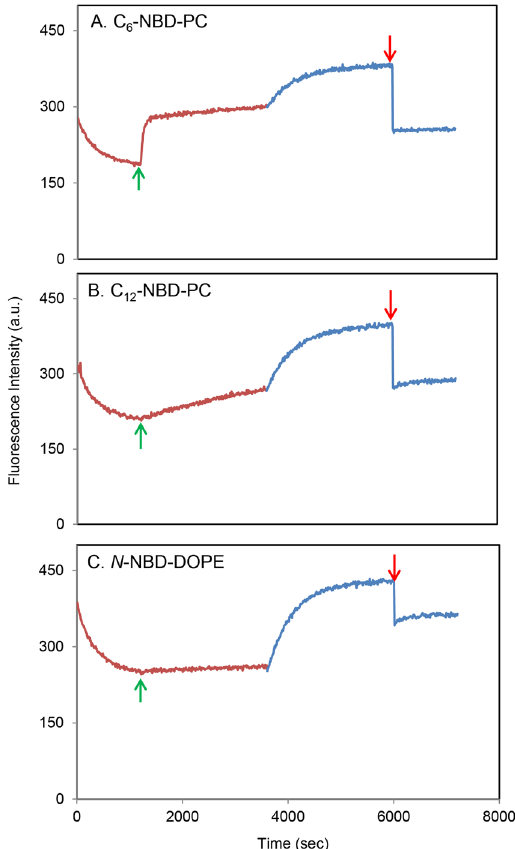
Figure 7. Spontaneous intermembrane transport of NBD lipids, C 6 -NBD-PC ( A ), C 12 -NBD-PC ( B ) and N -NBD-DOPE ( C ). Time course of NBD fluorescence emission in DOPC/ N -nitroBIPS-DPPG/NBD lipid (89:10:1) liposomes Representative data of three independent experiments. Red line, sample was concomitantly irradiated with blue green light (480 nm) and UV light (340 nm), activating NBD fluorescence quenching; blue line, sample was concomitantly irradiated with blue green light (480 nm) and green (543 nm) light, deactivating NBD fluorescence quenching; green arrow, indicates addition of acceptor liposomes; red arrow, indicates addition of Triton